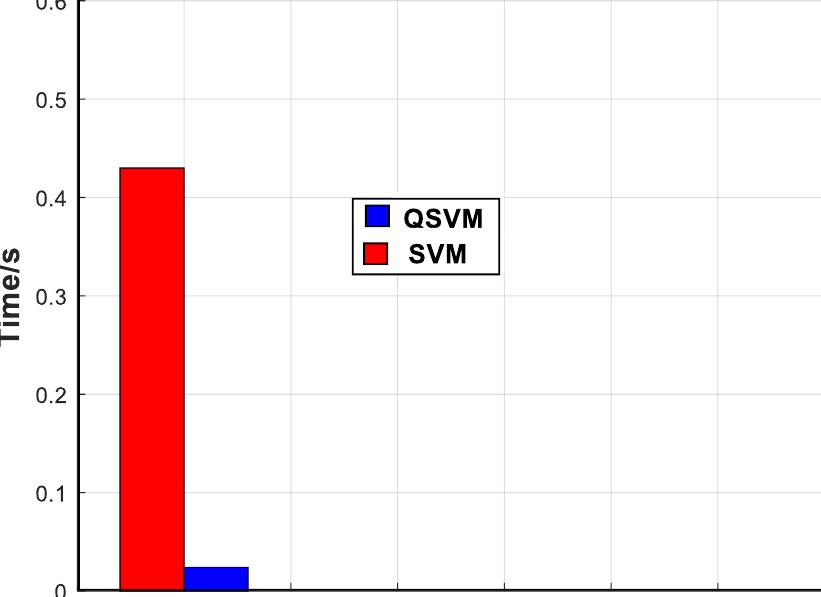
Figure 3. QSVM vs. SVM performance comparison: execution time.